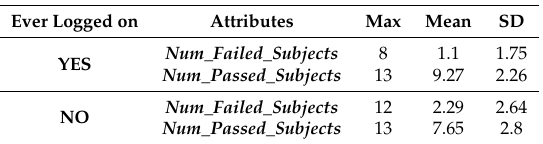
Table 3. Maximum, mean and standard deviation (SD) of the number of subjects failed and passed by students of all stages considering whether they have ever connected to the